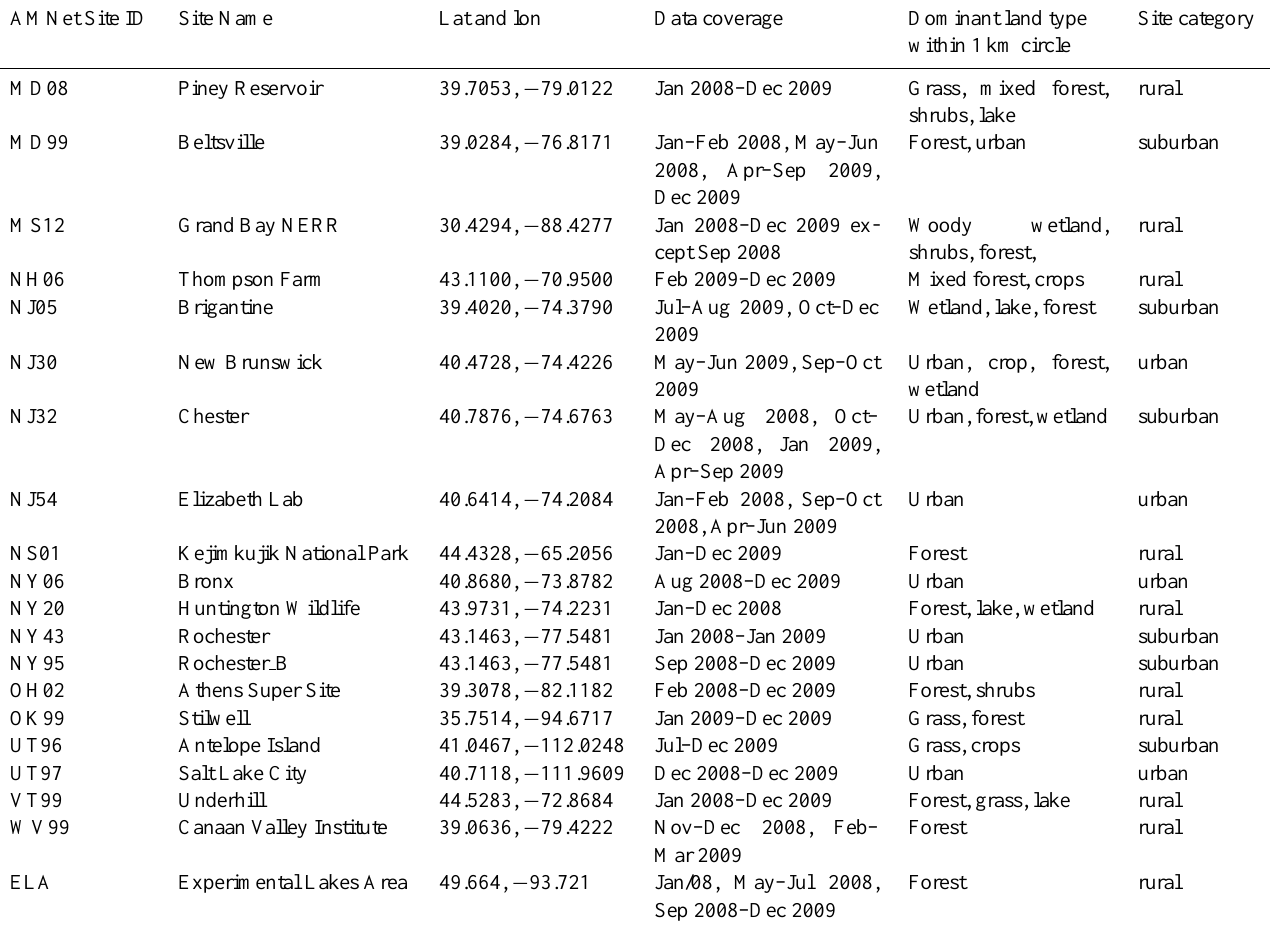
Table 1. List of AMNet site